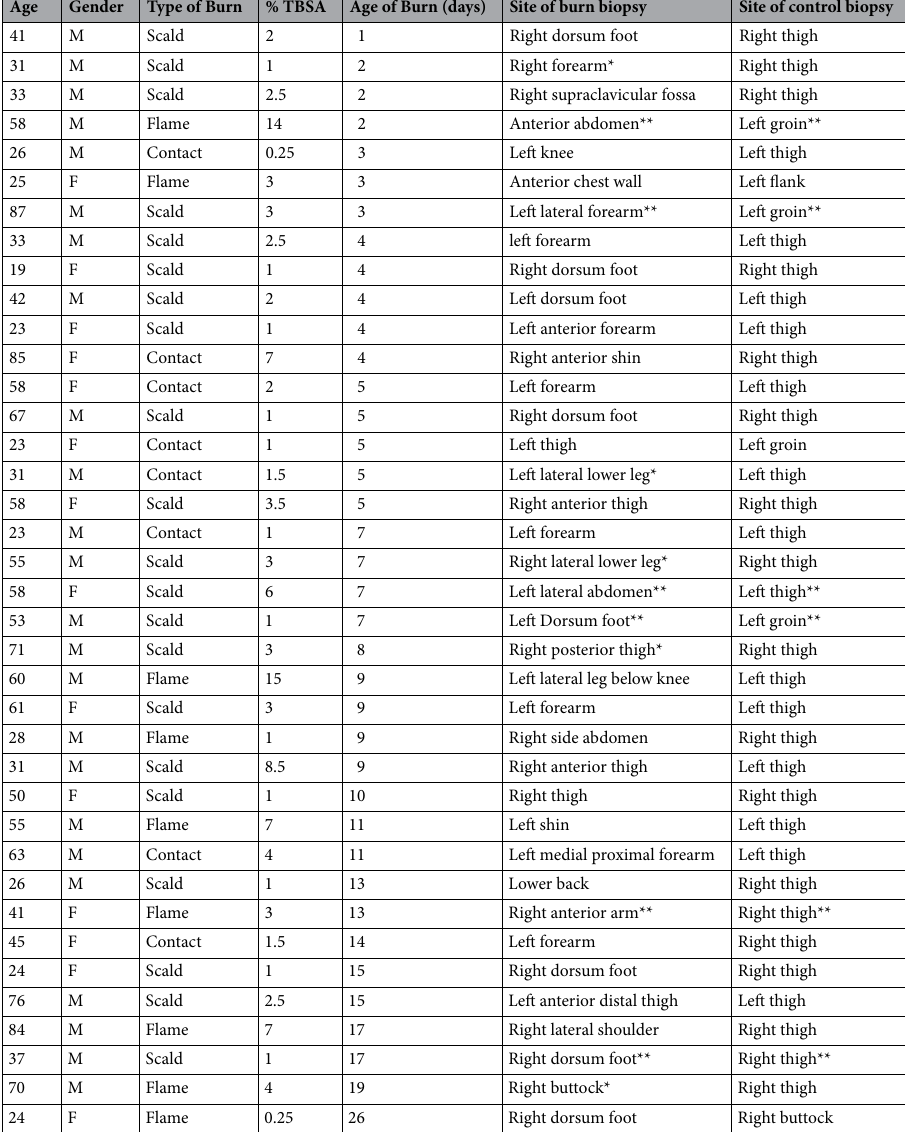
Table 1. Demographics of recruited patients. Demographics of patients recruited to study, and biopsy site (burn and uninjured control). Note *indicates those patients and biopsy sites underdoing additional formalin fixing and paraffin embedding (FFPE) and H&E staining; **indicates those biopsy sites undergoing FFPE and immunohistochemistry staining.